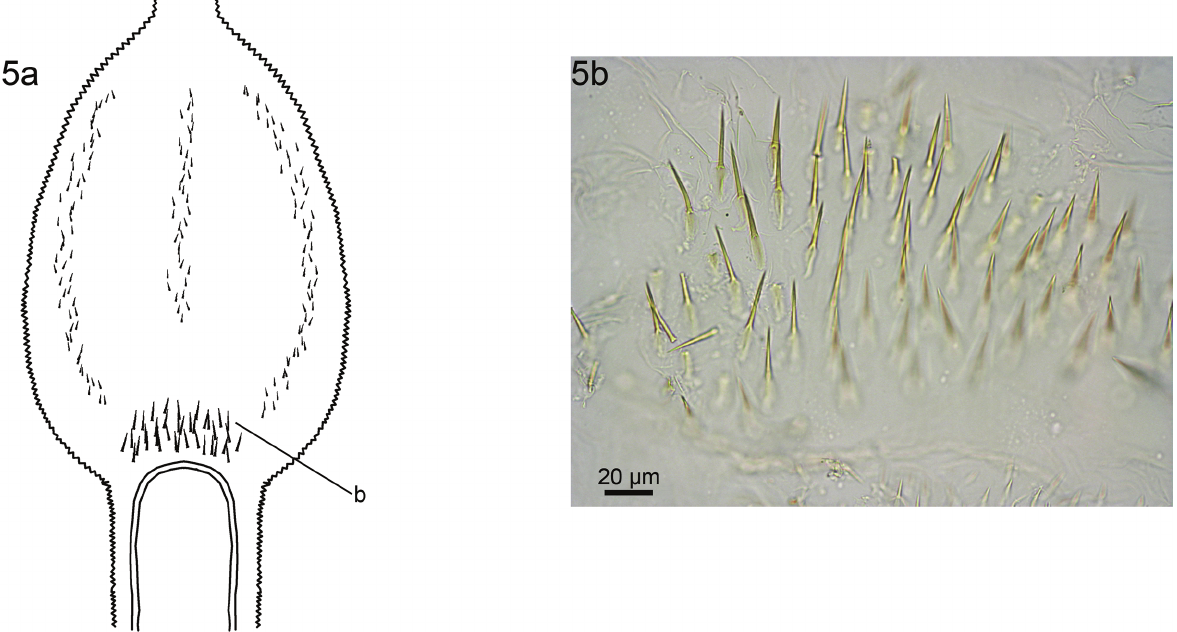
Figure 5. Curvitermes odontognathus . (a) Schematic drawing of P1 showing arrangement of spines; (b) Photomicrograph of set of aciculiform spines, positioned just after the mesenteric tongue.